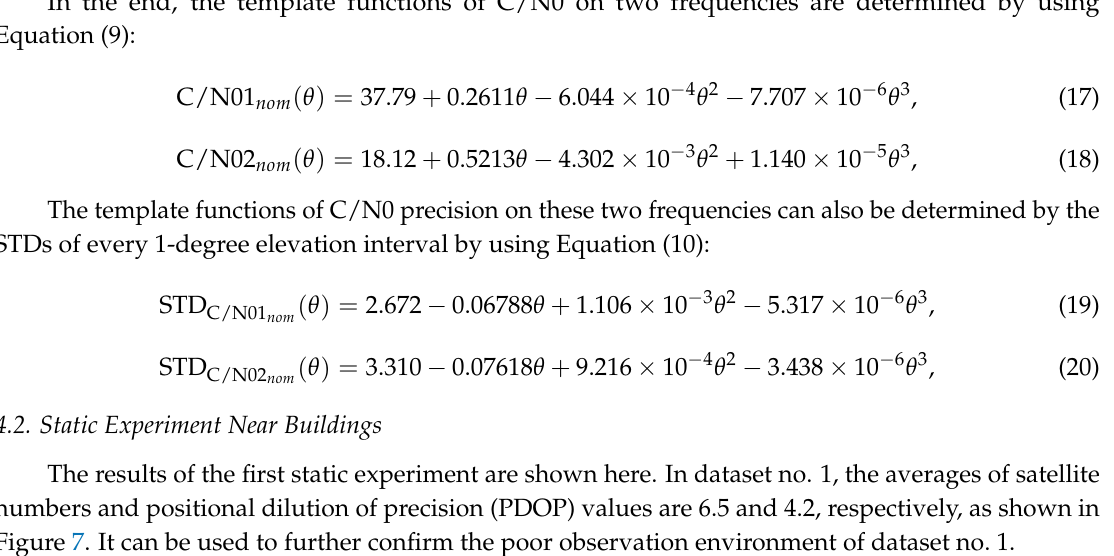
Figure 6. Refined reference C/N0 of C1 (C/N01) and P2 (C/N02) as a function of